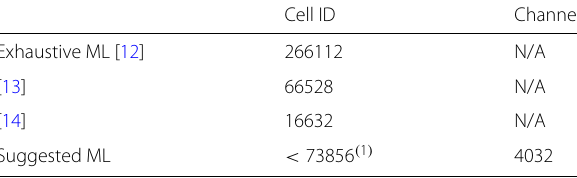
Table 2 Complexity comparison of the suggested DFT-based cell ID estimator with [12–14], in a number of complex multiplications Cell ID Channel Exhaustive ML [12] 266112 N/A [13] 66528 N/A [14] 16632 N/A Suggested ML < 73856 ( 1 )